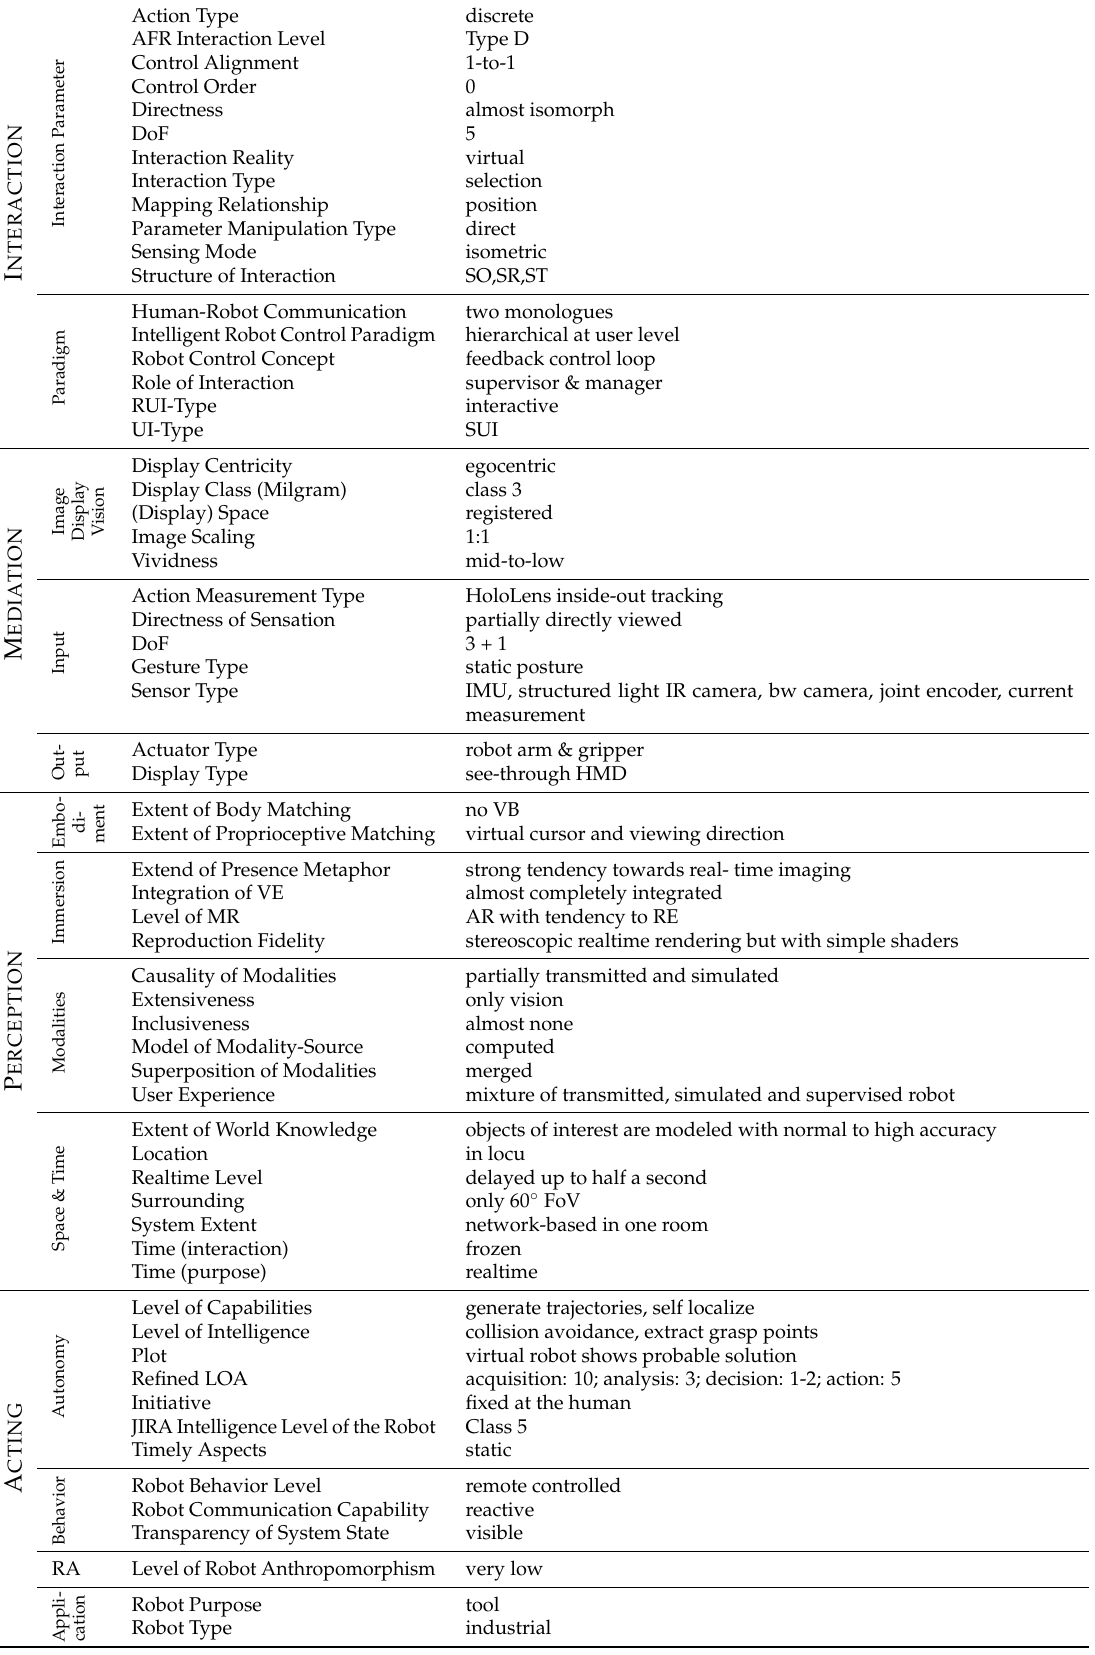
Table A2. Summary of Section 4 using the IMPAct